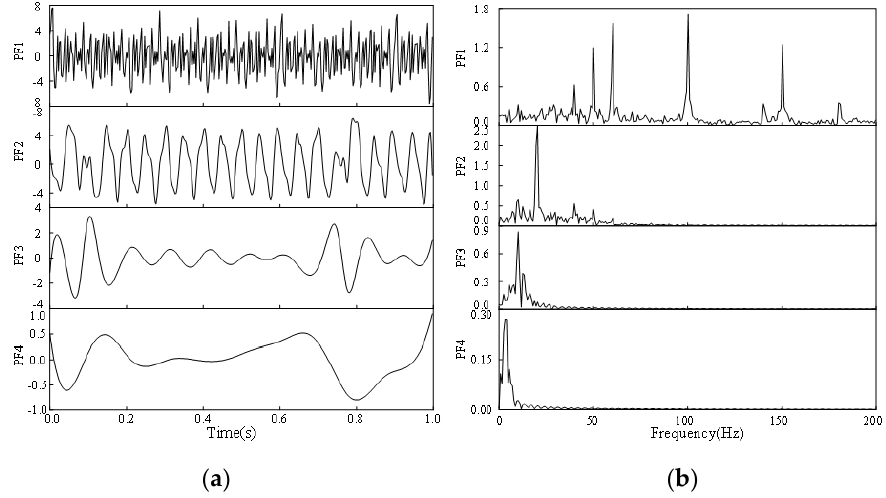
Figure 5. LMD decomposition result of the synthesized signal and its frequency spectrum. ( a ) LMD − decomposition − component waveform ( b ) LMD − decomposition − component frequency spectrum.